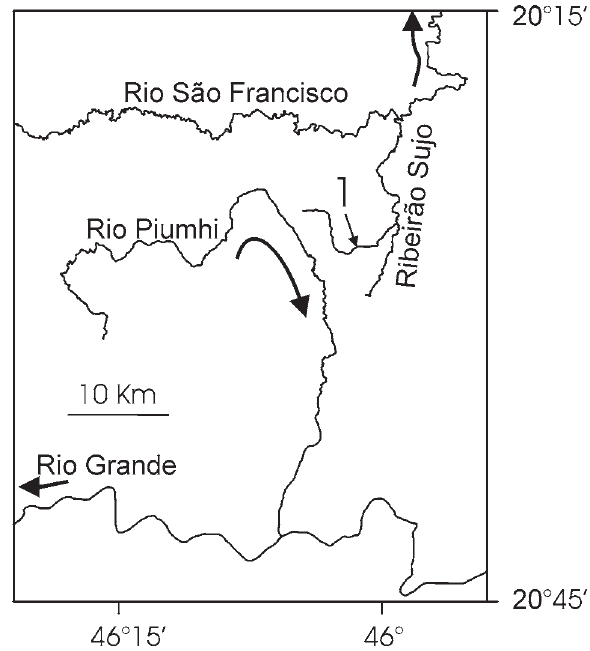
Fig. 1. Rio Piumhi prior to the construction of the Furnas Hydroelectric Dam. The Ribeirão da Água Limpa is indicated by the number 1.